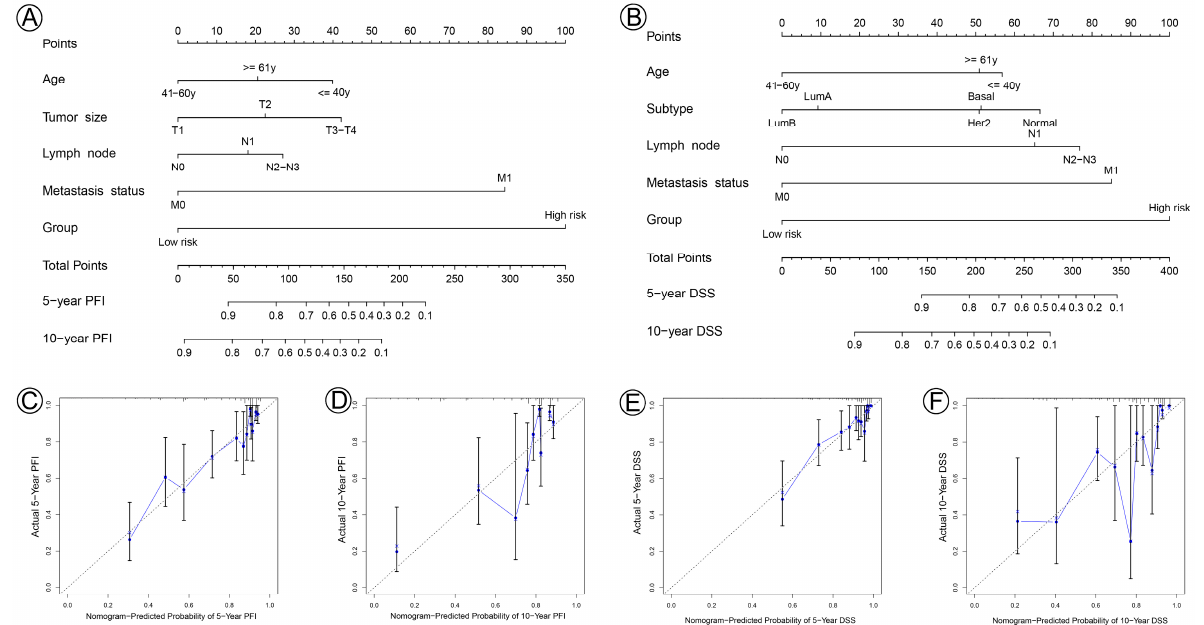
Figure 8. Nomogram for predicting 5- and 10-year PFI and DSS of patients with BC and calibration curves of the nomogram. ( A ) A nomogram incorporating age, tumor size status, lymph node status, metastasis status, and risk group was a predictor for 5- and 10-year PFI. ( B ) A nomogram incorporating age, molecular subtype, lymph node status, metastasis status, and risk group was a predictor for 5- and 10-year DSS. ( C , D ) Calibrated plots were applied to investigate the deviation in nomogram-predicted of 5- and 10-year PFI. ( E , F ) Calibrated plots were applied to investigate the deviation in nomogram-predicted of 5- and 10-year DSS.